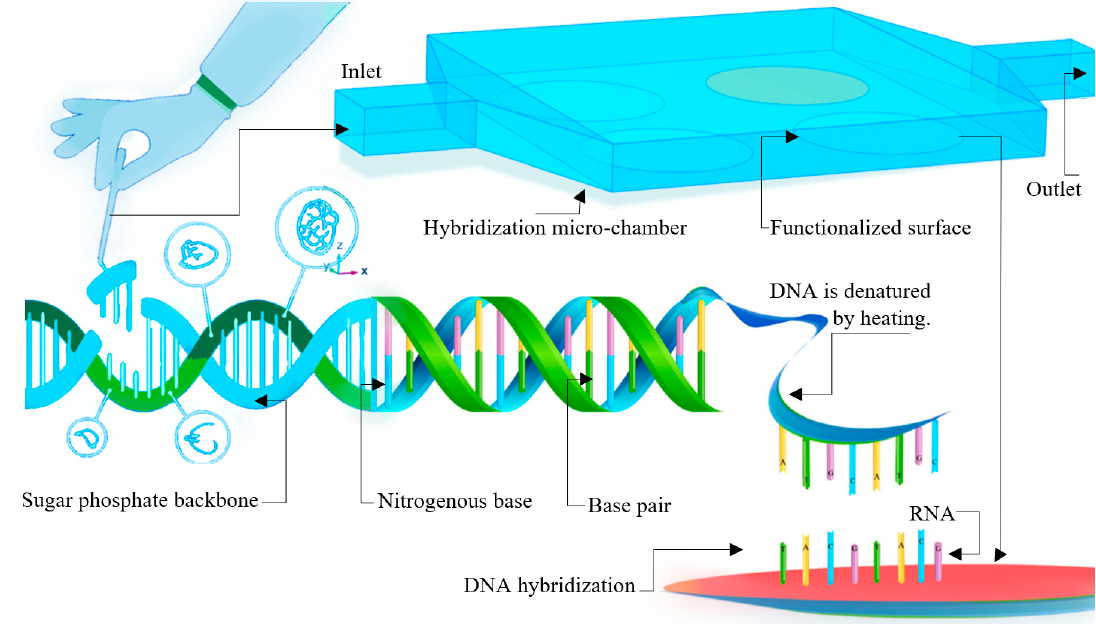
Figure 1. Bio-recognition process for DNA hybridization in a microchamber equipped with four functionalized surfaces for recognizing a specific sequence, dissociation of the double helix structure of the DNA, and hybridization with the functionalized surface.